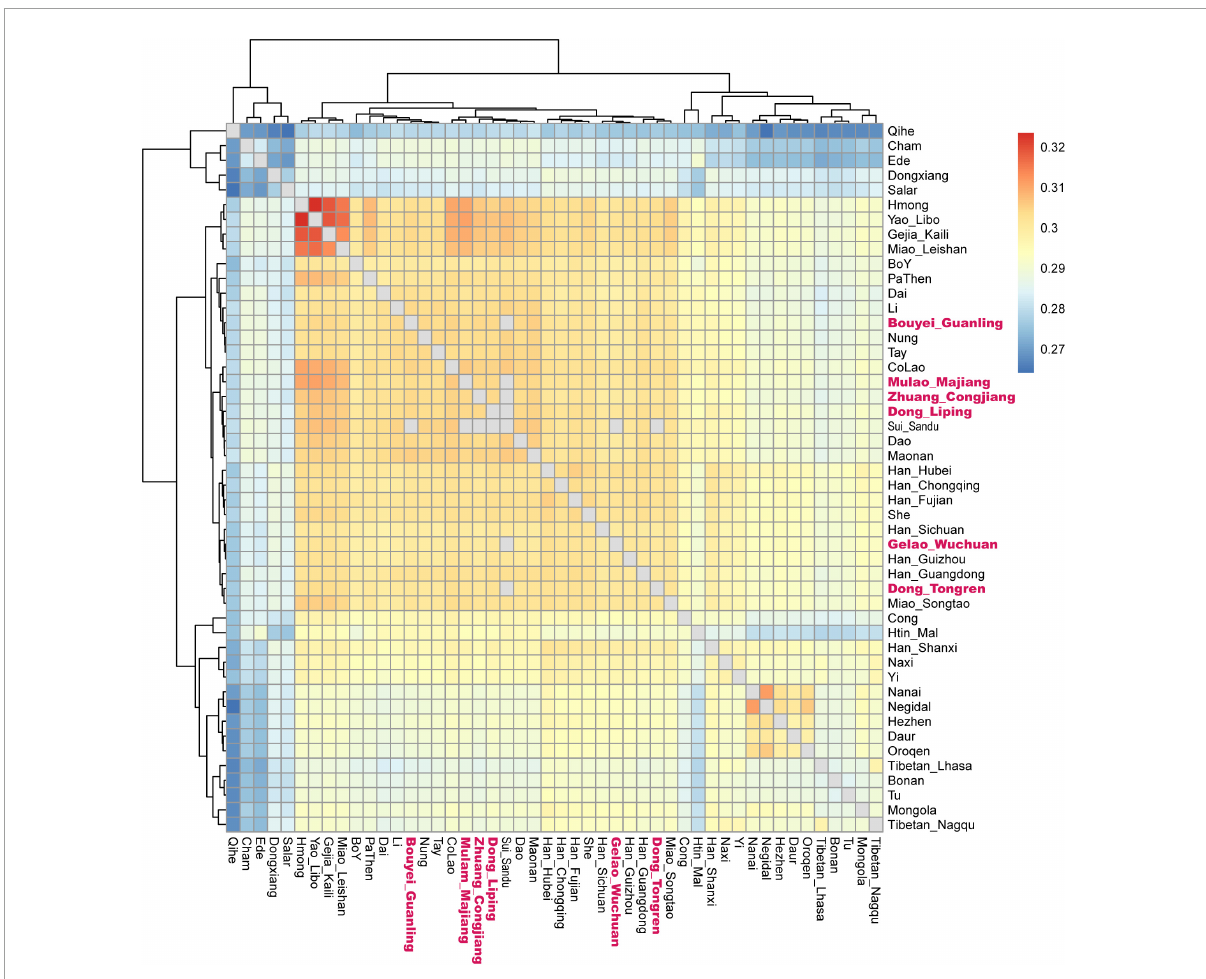
FIGURE4 Genetic relation between Guizhou Tai-Kadai-speaking population and reference populations based on outgroup-f3